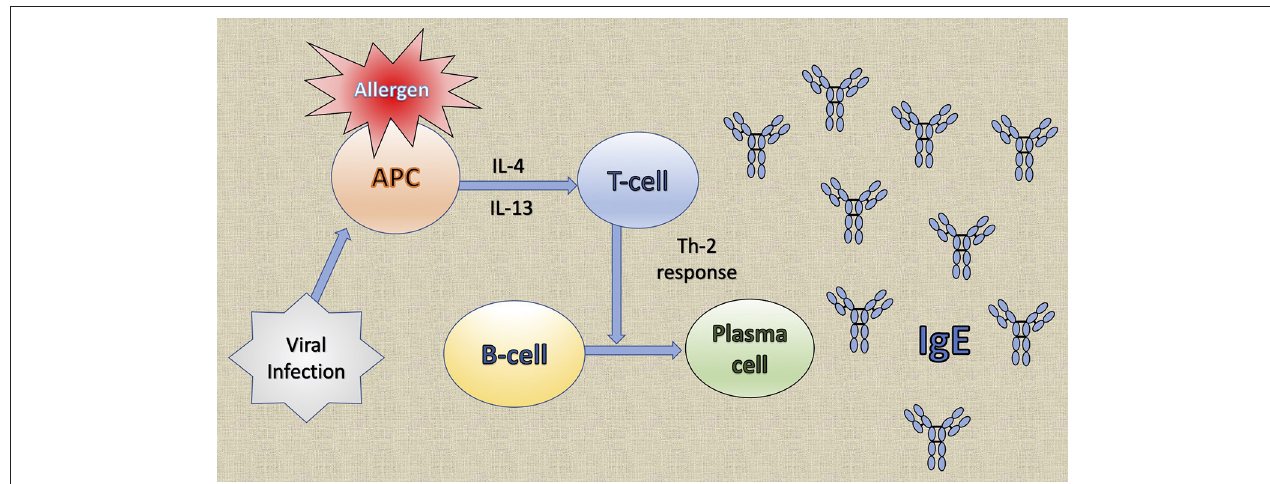
FIGURE 1 | The generation of immunoglobulin E (IgE) by plasma cells. Upon initial allergen exposure, antigen presenting cells (APC) capture, process and present allergen peptides to T-cells. In the presence of interleukin (IL)-4 or IL-13, T-cells acquire the Th2 phenotype, proliferate and stimulate B-cells to differentiate into plasma